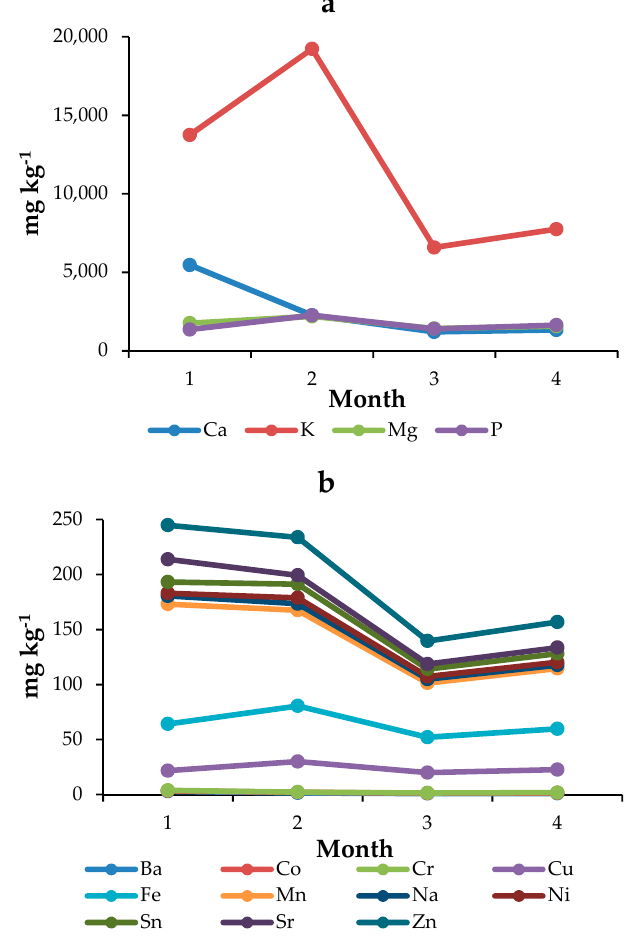
Figure 4. Trends of the element concentrations (mg · kg − 1 ) of ( a ) macro-nutrients and ( b ) micro-nutrients during the development of plants in hazelnuts sampled monthly on the roadside .